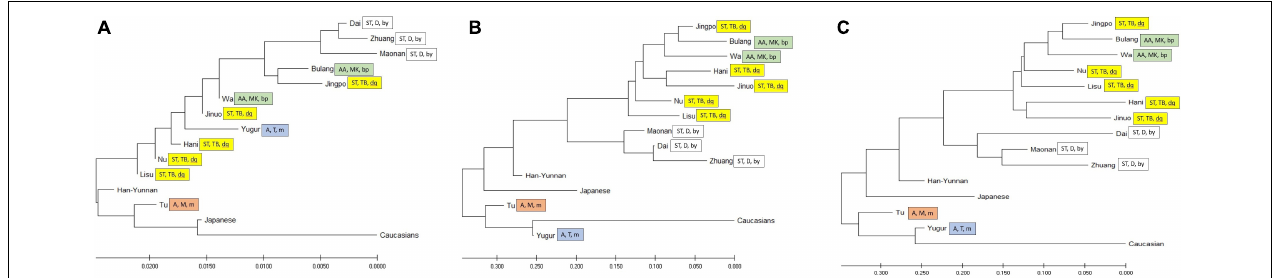
FIGURE 3 | Neighbor-joining trees. (A) Neighbor-joining tree based on DA genetic distance from five POALIN allele frequencies. (B) Neighbor-joining tree based on HLA-DRB1 allele frequencies. (C) Neighbor-joining tree based on the DRB1/AluDRB1 haplotype frequencies. The colored labeled boxes represent the ancient tribe, language family and subfamily for each population listed in Table 1 . Yellow represent Di-Qiang, Sino-Tibetan, Tibeto-Burman. Green represent Baipu, Austo-Asiatic, Mon-Khmer. White represent Baiyue, Sino-Tibetan, Daic. Orange represent Mongolian, Altaic, Mongolian. Blue represent Mongolian, Altaic,